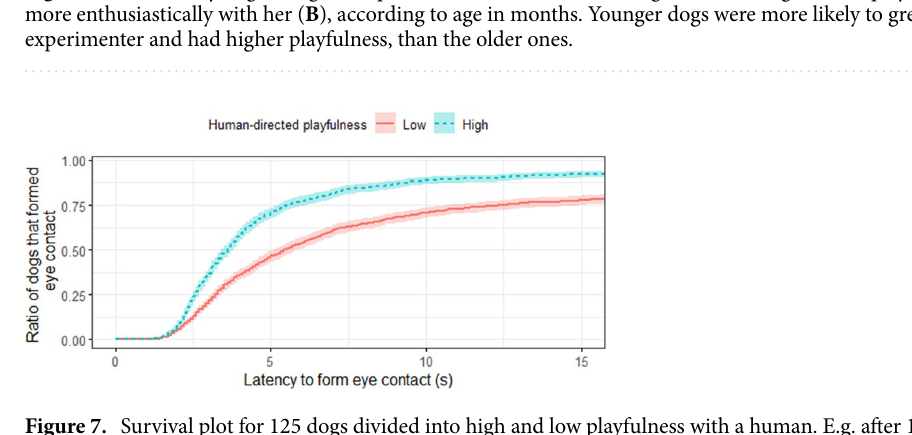
Figure 7. Survival plot for 125 dogs divided into high and low playfulness with a human. E.g. after 10 s elapsed, usually ~ 90% of dogs with high playfulness had already formed eye contact with the experimenter, while at the same time only ~ 75% of dogs with low playfulness did